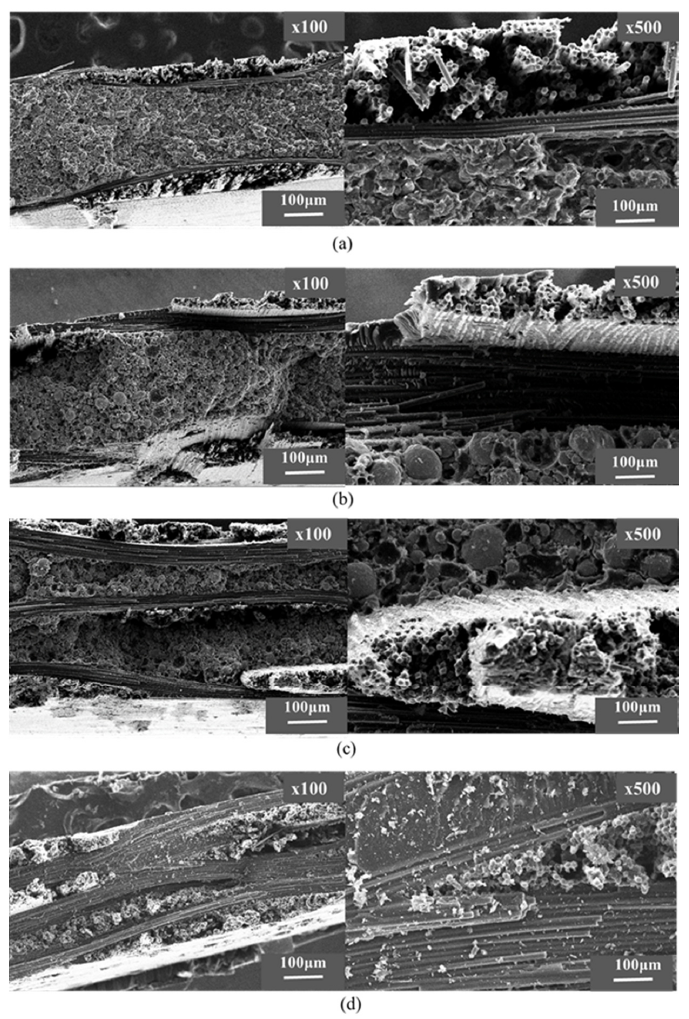
Figure 10. Fractography images of the composites after tensile test: ( a ) CF-FeSi-1; ( b ) CF-FeSi-2; ( c ) CF-FeSi-3; ( d ) CFRP(four-ply).